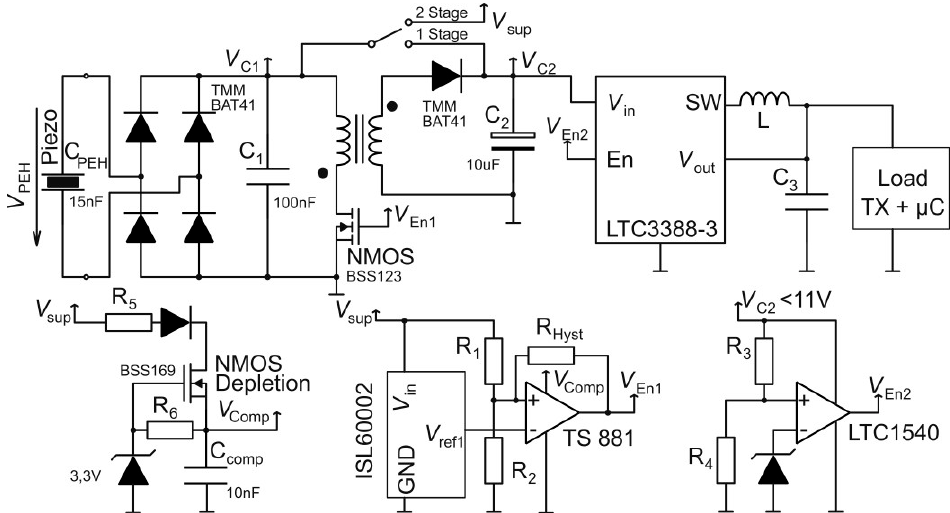
Figure 3. Schematic of the proposed two-stage circuit for optimal energy extraction of piezoelectric energy harvesters.